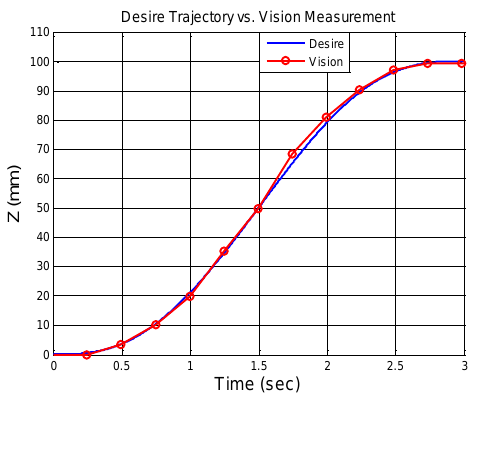
Figure 17. Stereo vision measuring results of a fifth order trajectory with stroke of 100 mm.